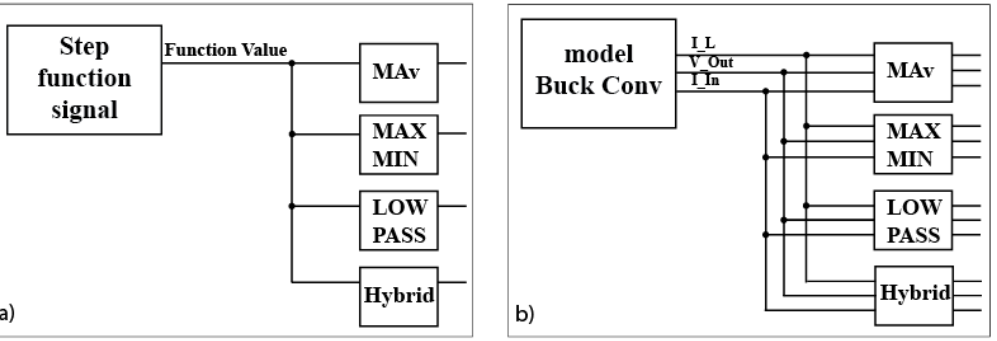
Figure 7. Architecture of the experiments shown in this section. ( a ) Model of the step function signal connected to the filters. ( b ) Model of the buck converter, connected to the filters.